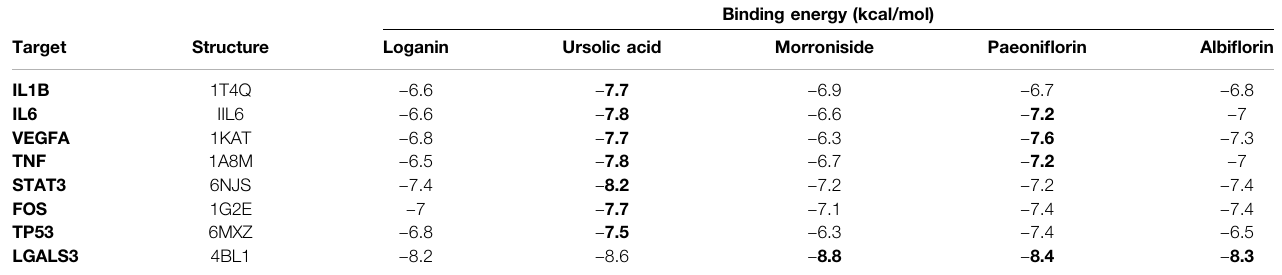
TABLE 5 | Binding energy between selected targets and active compounds investigated in this study.